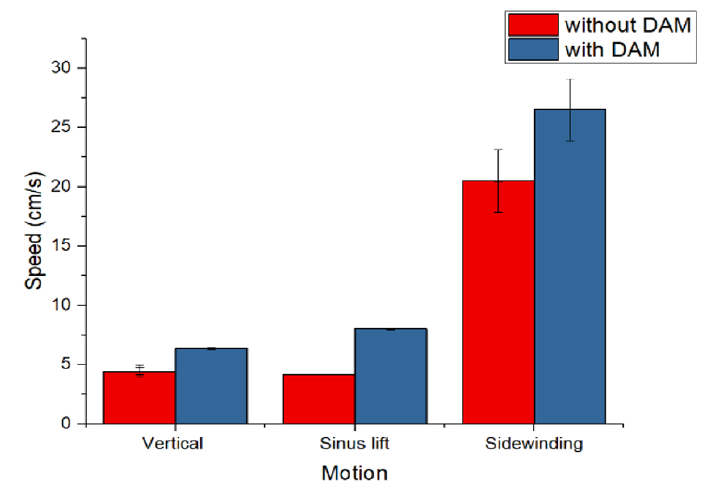
Figure 16. Locomotion speed for three movement types when the DAM was attached and when the DAM was not attached.